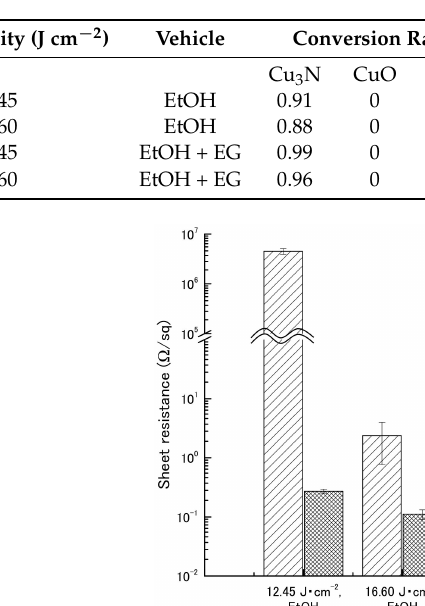
Table 2. Conversion ratio and sheet resistance obtained with different irradiation energy densities and vehicles.